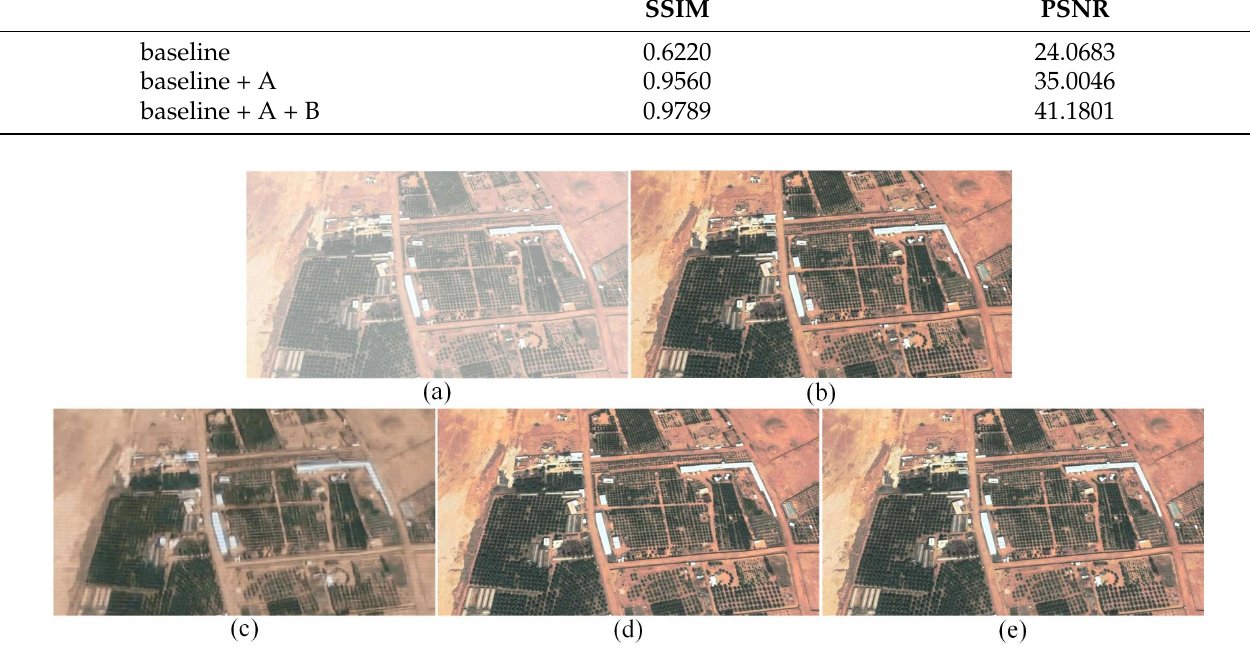
Figure 14. Results of ablation study. ( a ) shows the synthetic foggy remote sensing image; ( b ) shows the original fog-free remote sensing image; ( c ) shows the defogged image obtained by baseline; ( d ) shows the defogged image obtained by baseline + A; ( e ) shows the defogged image obtained by baseline + A +